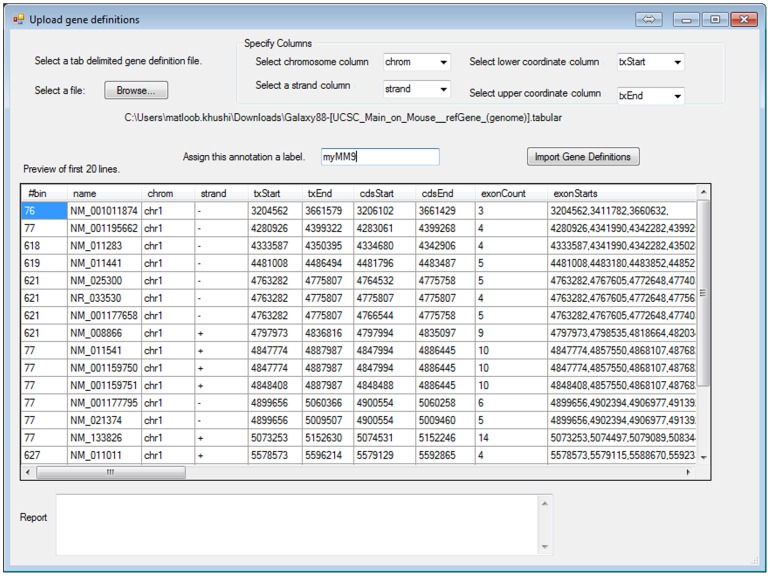
New gene definitions.New gene definitions may be uploaded in the software. The user must specify columns for chromosome, strand, lower and upper coordinates.